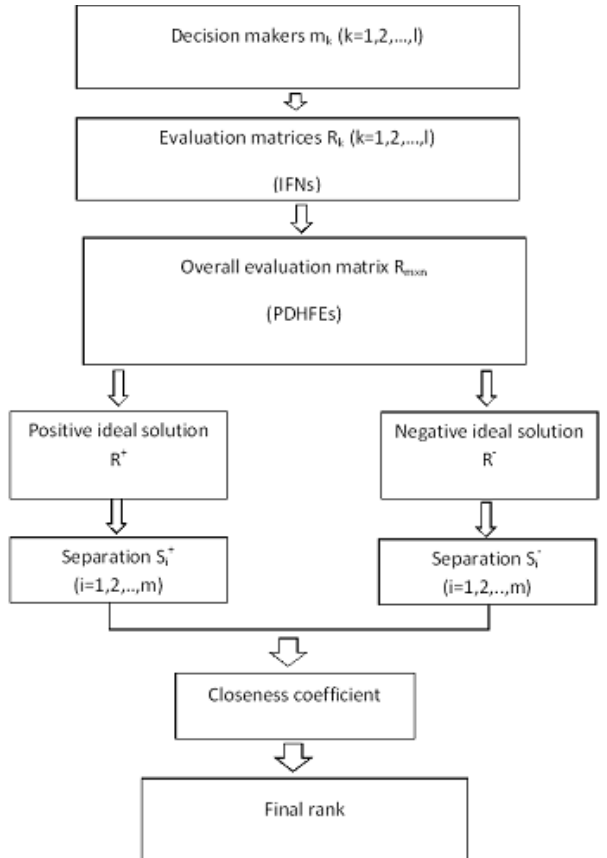
Figure 1. Proportional dual hesitant fuzzy TOPSIS approach.